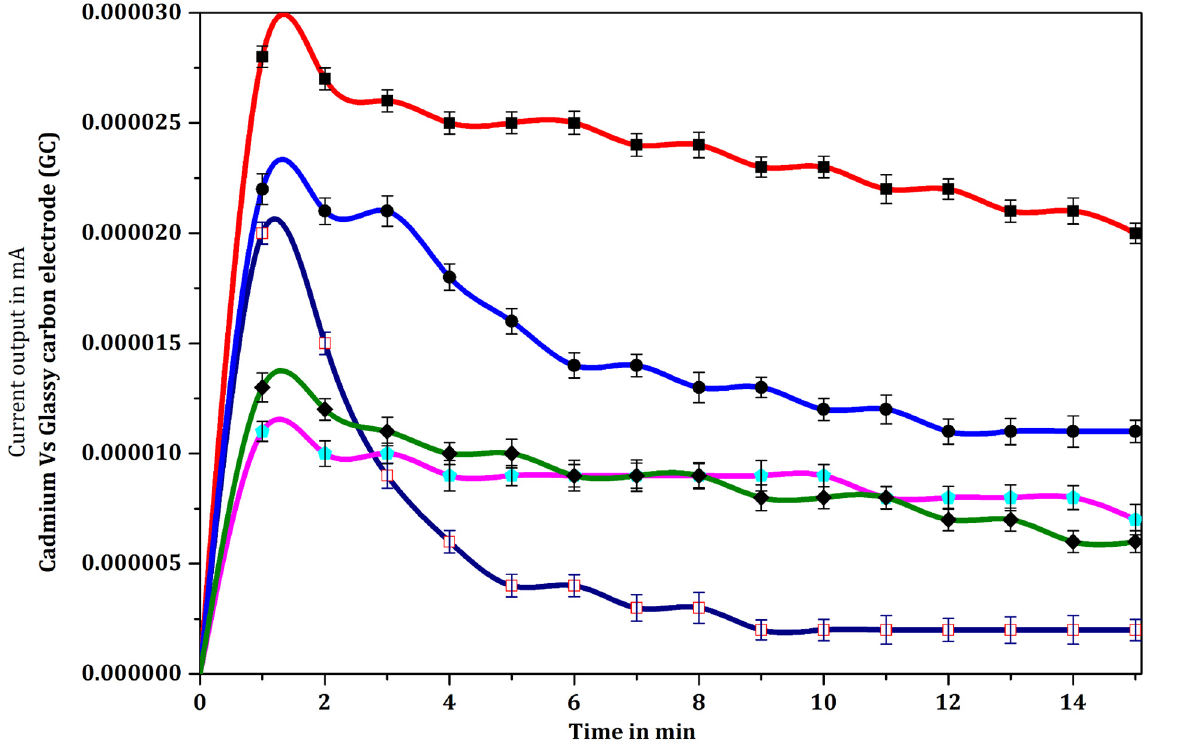
Figure 10. Response signal output current curves for the glassy carbon electrode with PBS ( ), and with various dilutions of immobilized mouse anti- Salmonella monoclonal antibody (MCA) on the glassy carbon electrode viz. 1:30,000 ( ). In each case the electrode was prepared with a constant attached PBS pH 7.2. Data represent mean ± SD (n = 5).